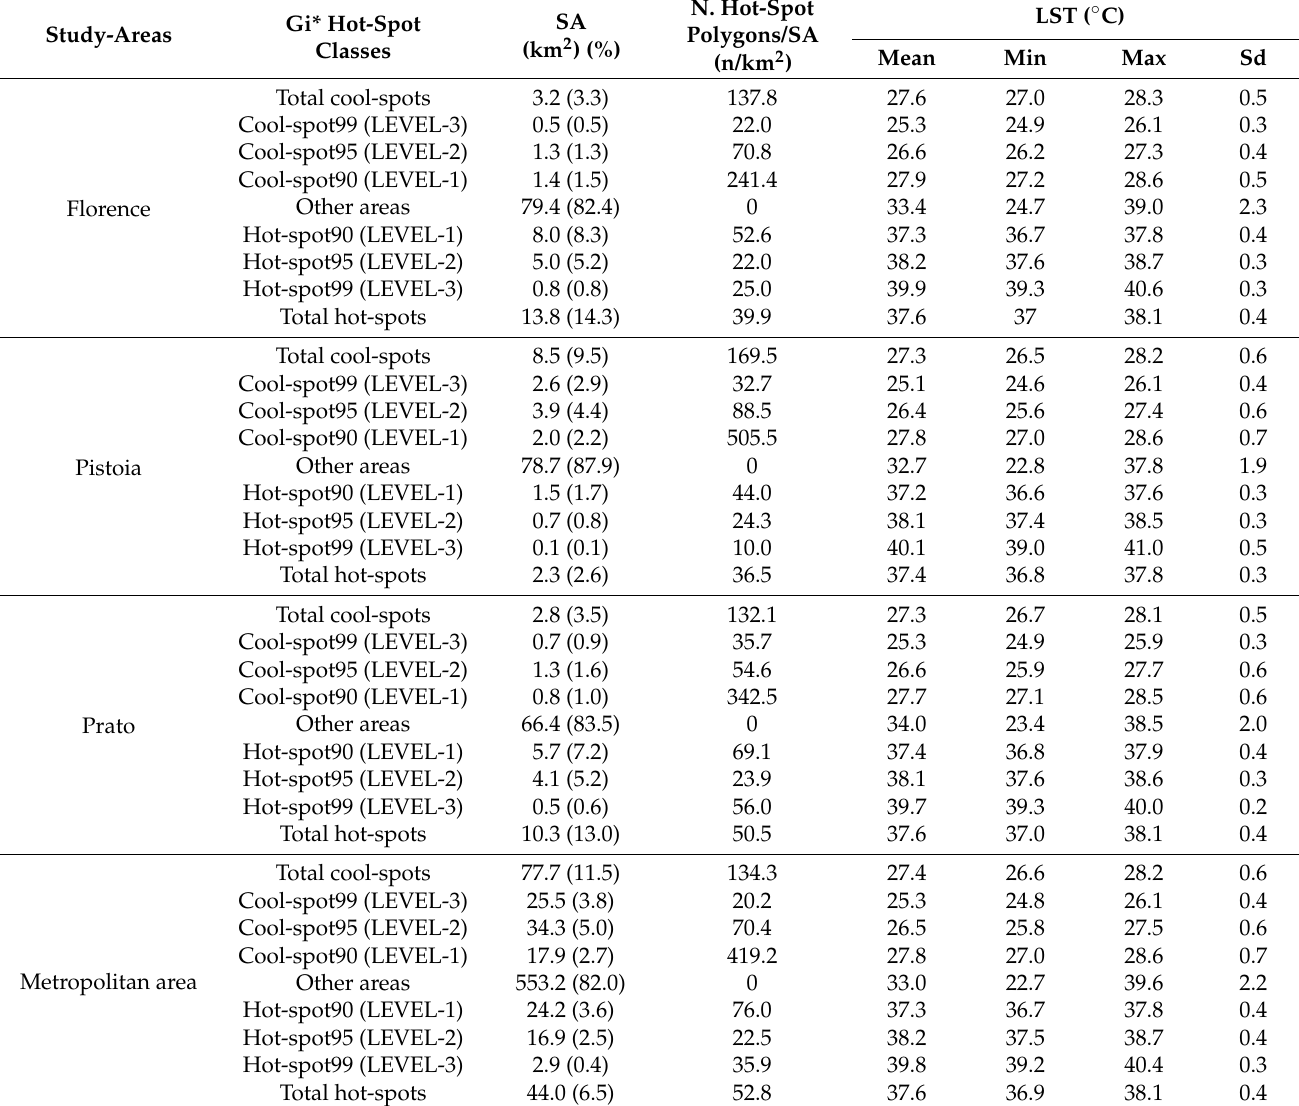
Table 3. Percentage coverage area of Gi* hot-spot classes with relative averaged values of LST.